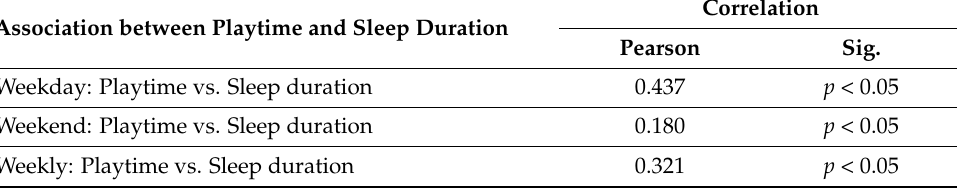
Table 3. Correlations between playtime and sleep duration before and during COVID-19 pandemic. Association between Playtime and Sleep Duration